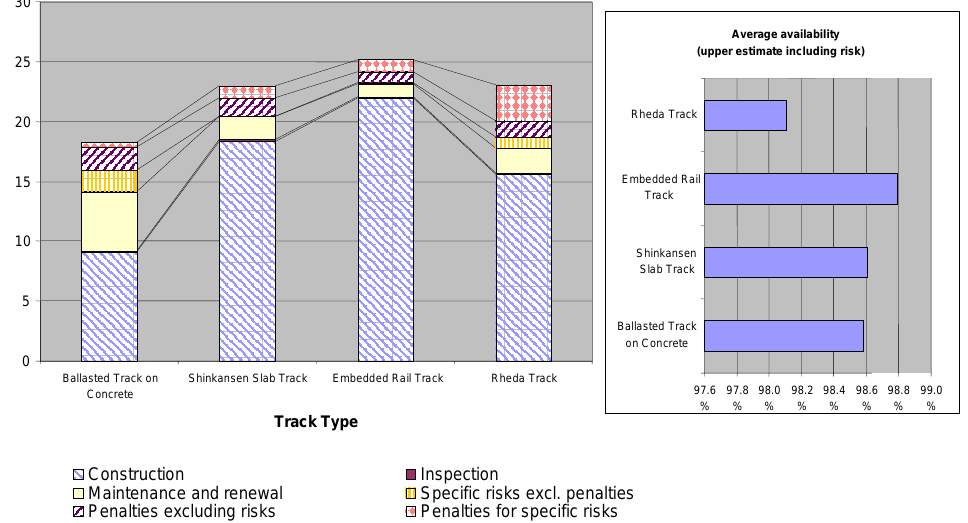
Figure 10. Performance fees for a specific scenario (for illustration purposes